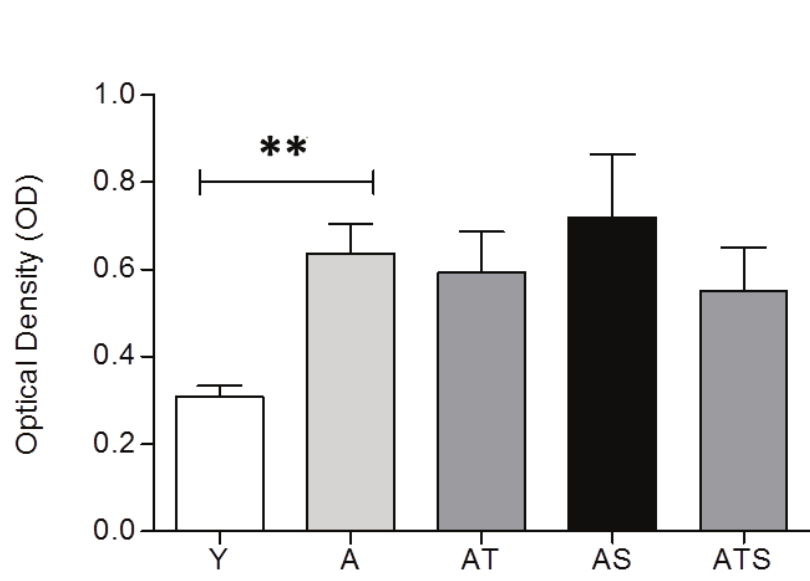
Figure 5. Plasma non-esterified fatty acid (NEFA) levels in different study groups. Plasma NEFA concentrations were significantly increased with all aged groups, but remained unaffected by sucrose ± SAMEC. ** p < 0.01.